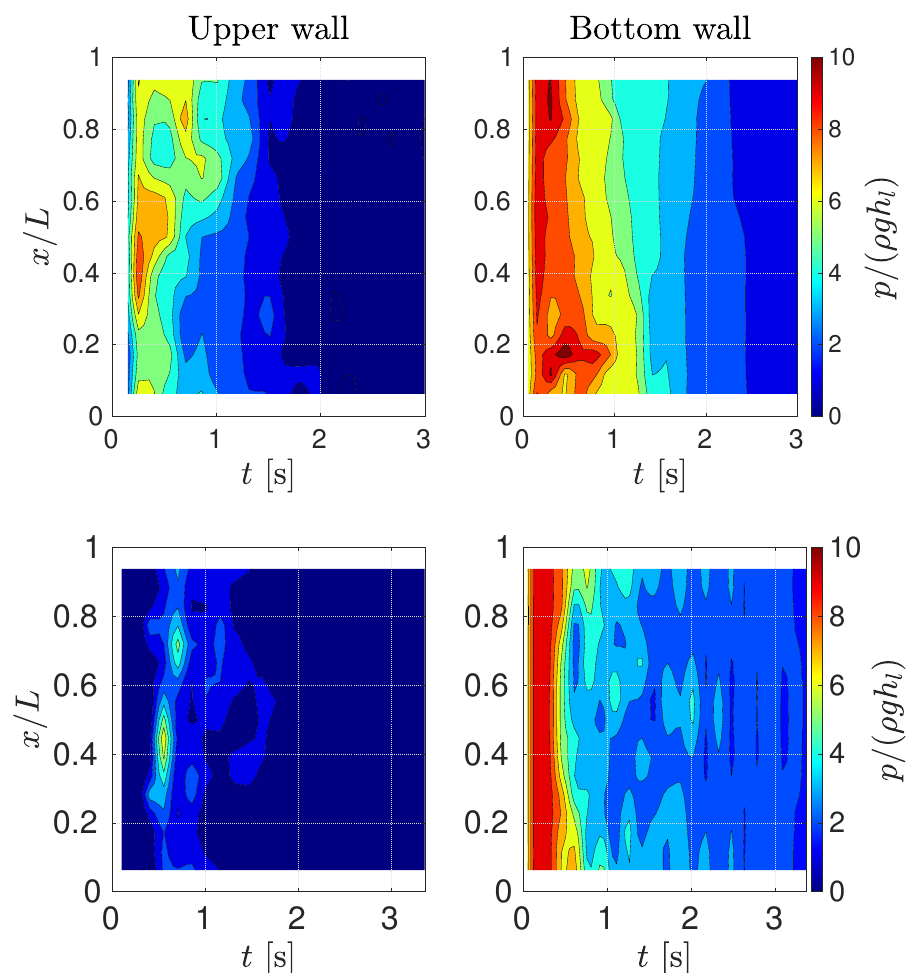
Figure 20. Nondimensional pressure maxima as a function of time and x coordinate for the upper ( left ) and bottom wall ( right ) in the water case at f = 0.5 ( top ) and glycerine case at f = 0.39 ( bottom ). The contour plot has been interpolated using 17 pressure signals for each